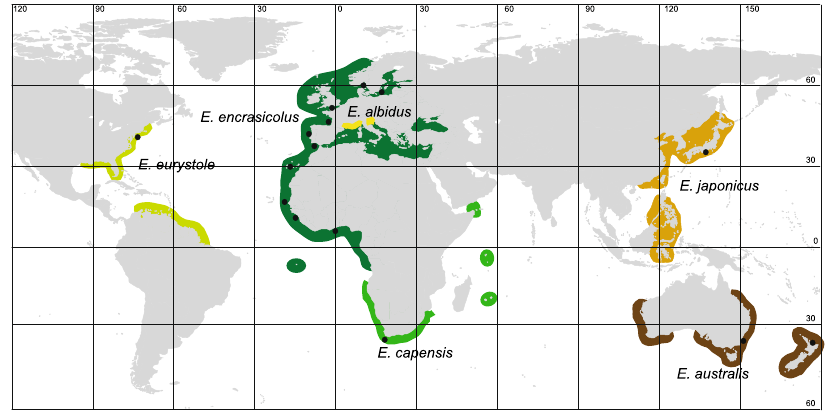
Figure 1. Present-day distribution of nominal Old World Anchovies species 10 ; black dots represent sample locations; raw map was downloaded from https://freevectormaps.com/ and edited in Adobe Illustrator CS5.1 (Adobe Systems Inc., CA,